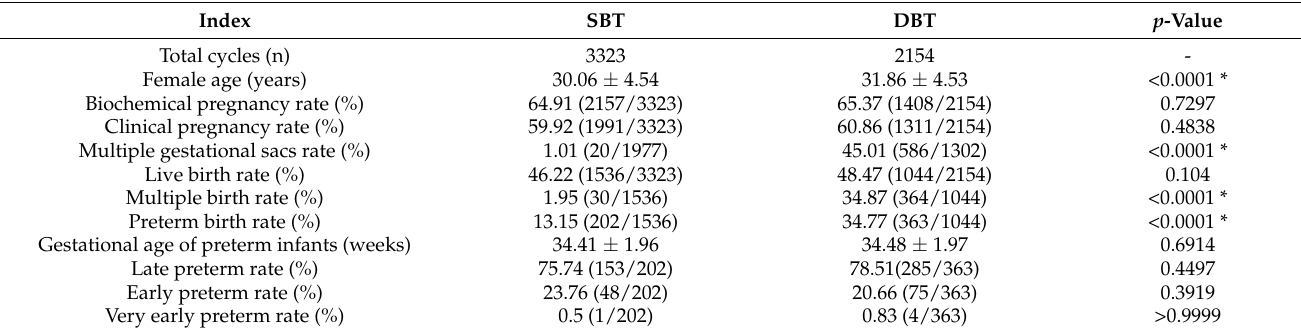
Table 1. Clinical outcome of single blastocyst transfer group (SBT) versus double blastocyst transfer group